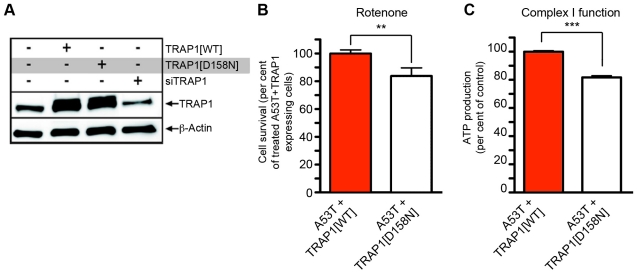
Effect of TRAP1 mutation on modification of [A53T]α-Synuclein toxicity.(A) Western blot analysis of HEK293 lysates transfected with indicated constructs showed similar expression levels of TRAP1[WT] and TRAP1[D158N] and a reduction of endogenous TRAP1 by siTRAP1. Blot was probed with TRAP1-specific antibody. ß-Actin served as loading control. (B, C) Effect of TRAP1[WT] and TRAP1[D158N] on [A53T]α-Synuclein-induced effects in HEK293 cells. (B) Effect of TRAP1[D158N] on [A53T]α-Synuclein-induced toxicity. Cell survival after rotenone (200 µM) treatment was monitored. Compared to TRAP1[WT], cells expressing TRAP1[D158N] displayed a significant reduction in survival (t-test, **p<0.01). (C) Assessment of ATP production via Complex I in unstressed cells with [A53T]α-Synuclein expression revealed a significant reduction of ATP levels in TRAP1[D158N] versus TRAP1[WT] expressing cells (t-test, ***p<0.001).